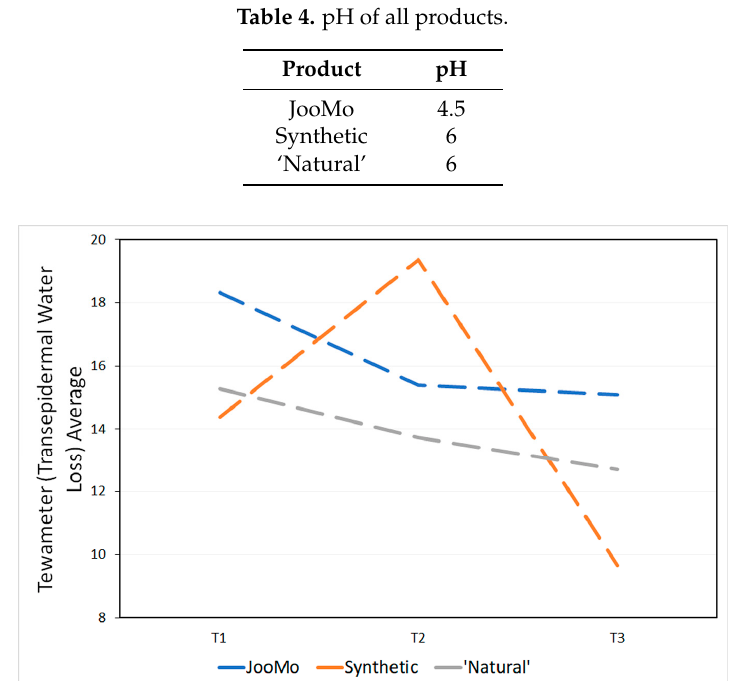
Figure 13. Tewameter (TEWL) averages at all time points. Table 5. Average percentage change in TEWL for all product groups.